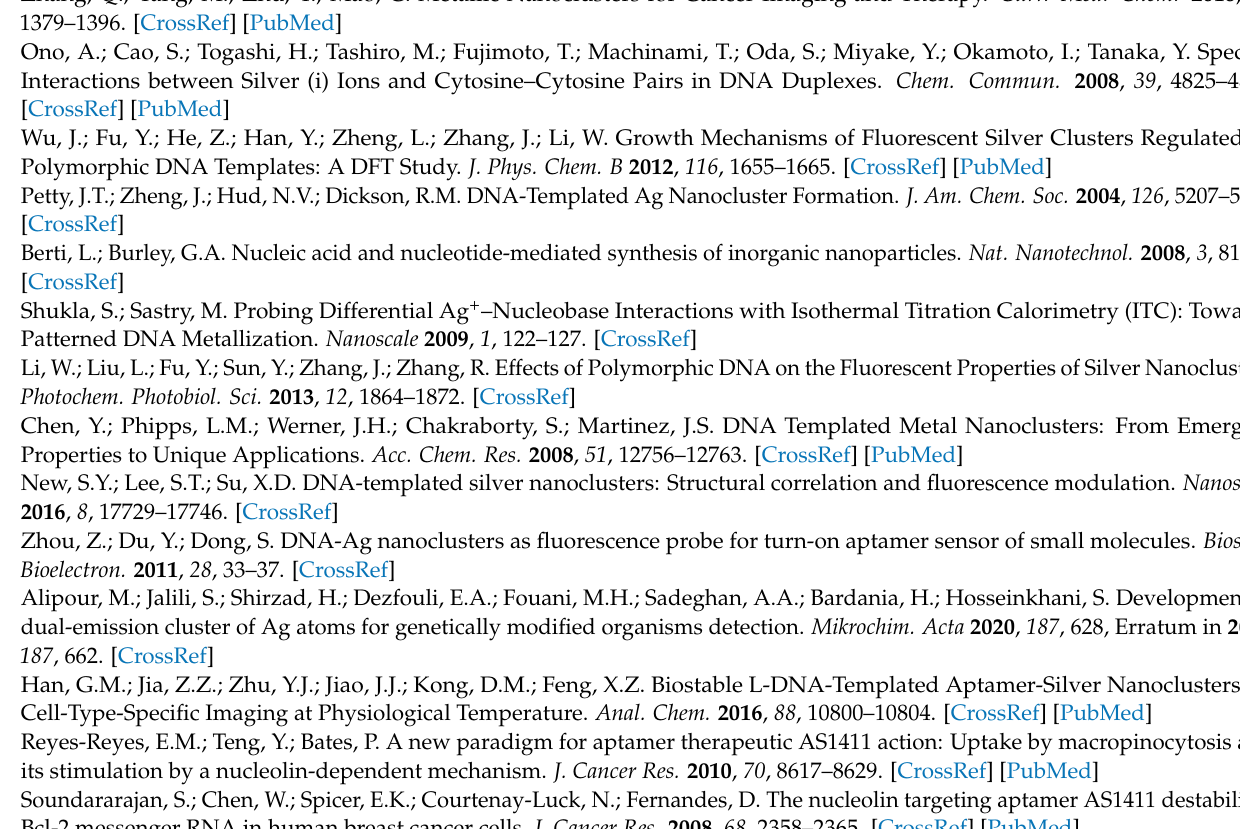
Figure S16: Circular dichroism spectra of Tel22C12-AgNCs with cytosine to Ag + ratio 1:1 (Ag + /C) upon titration with KCl (a) and NaCl (b); Figure S17: Circular dichroism spectra of TBAC12-AgNCs with cytosine to Ag + ratio 1:1 (Ag + /C) upon titration with KCl (a) and NaCl